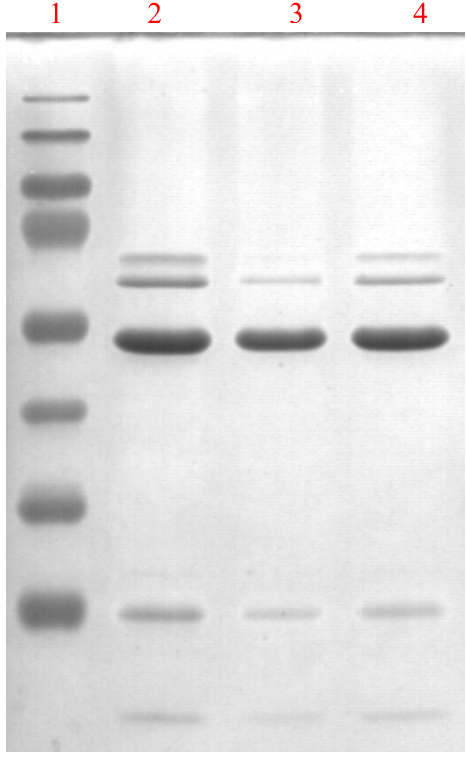
Figure 4. SDS/PAGE of recombinant ALDH3A1 after purification: lane 1, PageRuler (Fermantas) molecular mass marker proteins (from bottom to top: 26, 34, 43, 55, 72, 95, 130, 170 kDa); lane 2, solution from the first elution; lane 3, solution from the second elution; lane 4, eluate after dialysis. The gel was stained with Coomassie Brilliant